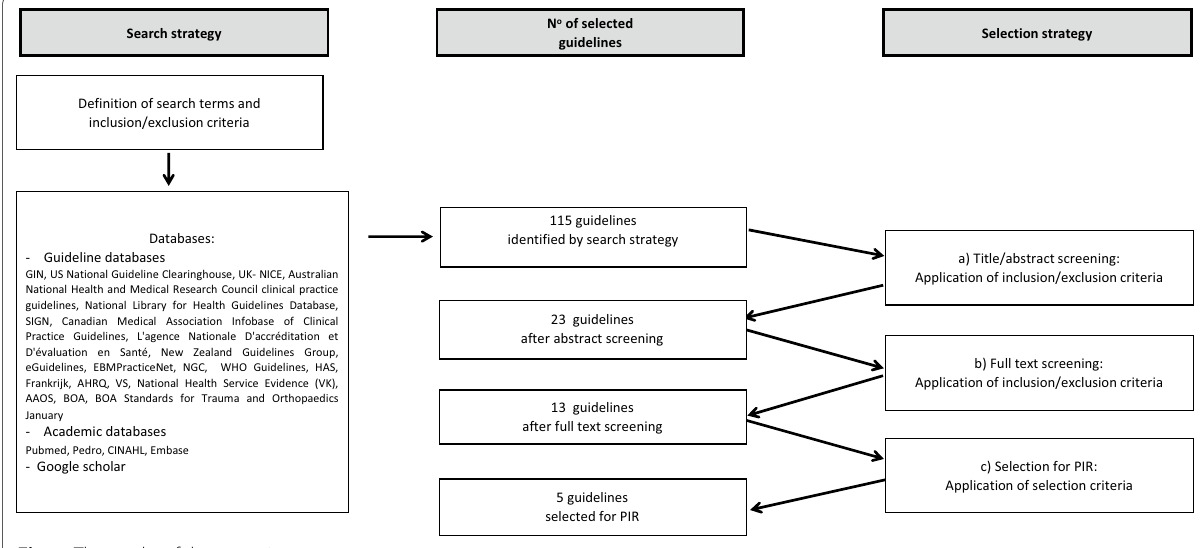
Fig. 1 The results of the screening